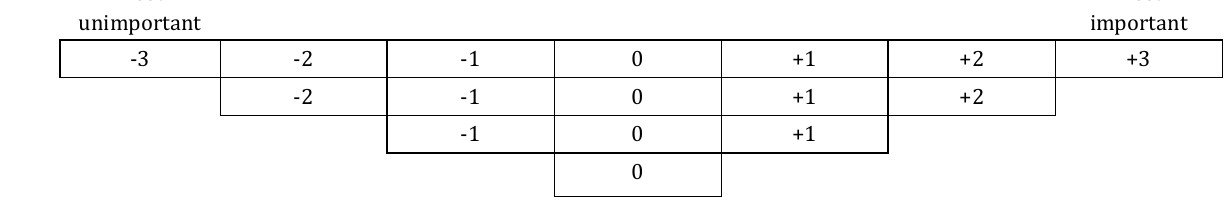
Table 1. Q-sort ranking used for assessing statement scores